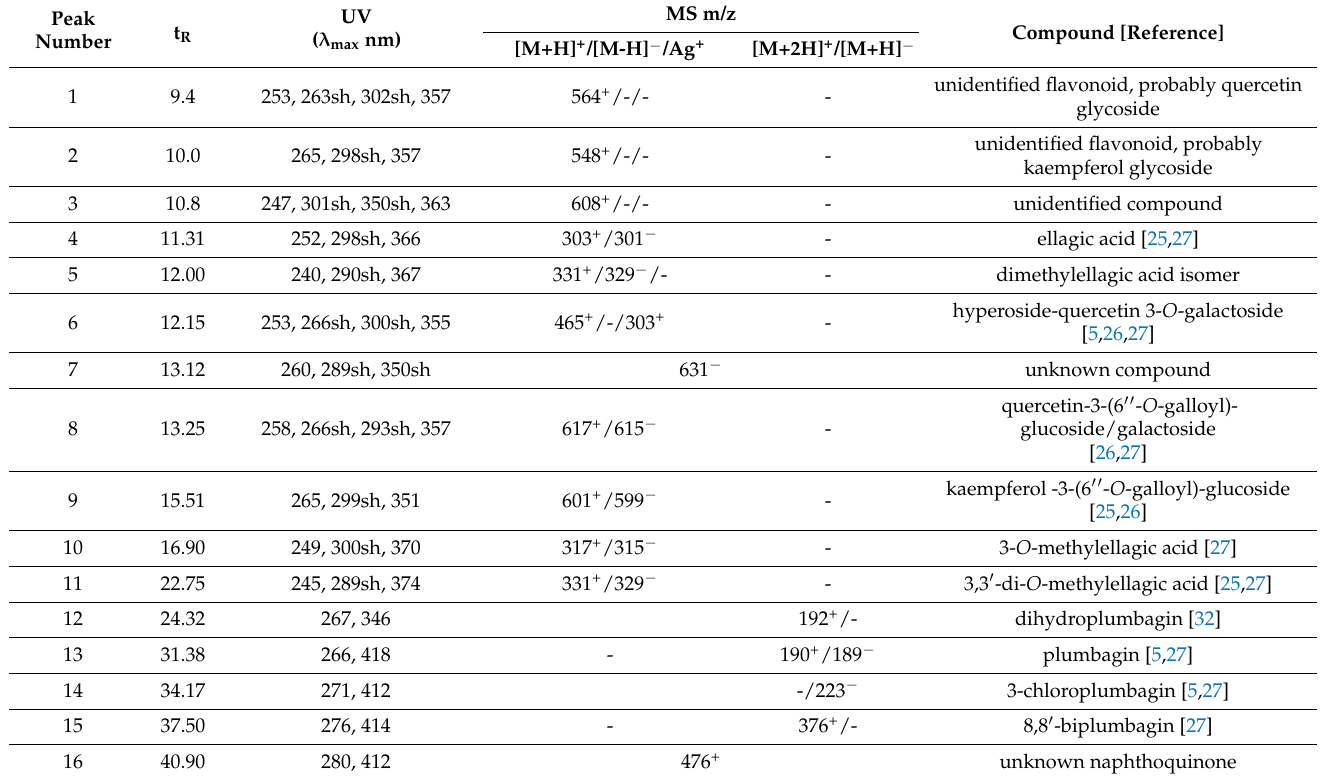
Table 3. HPLC-DAD-ESI/MS data [t R (min), UV